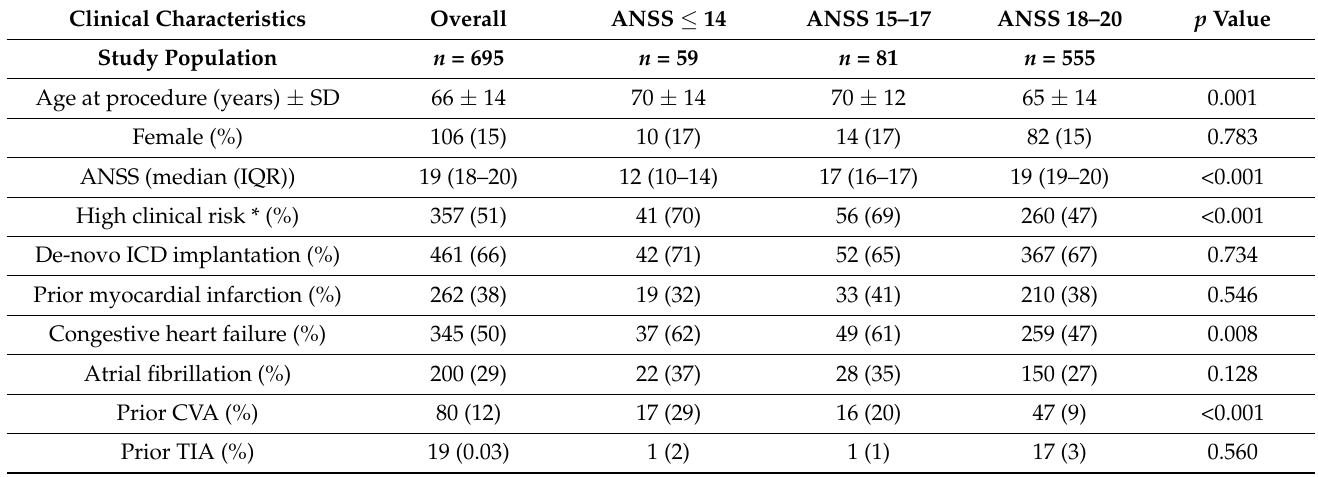
Table 1. Baseline characteristics by admission Norton scale